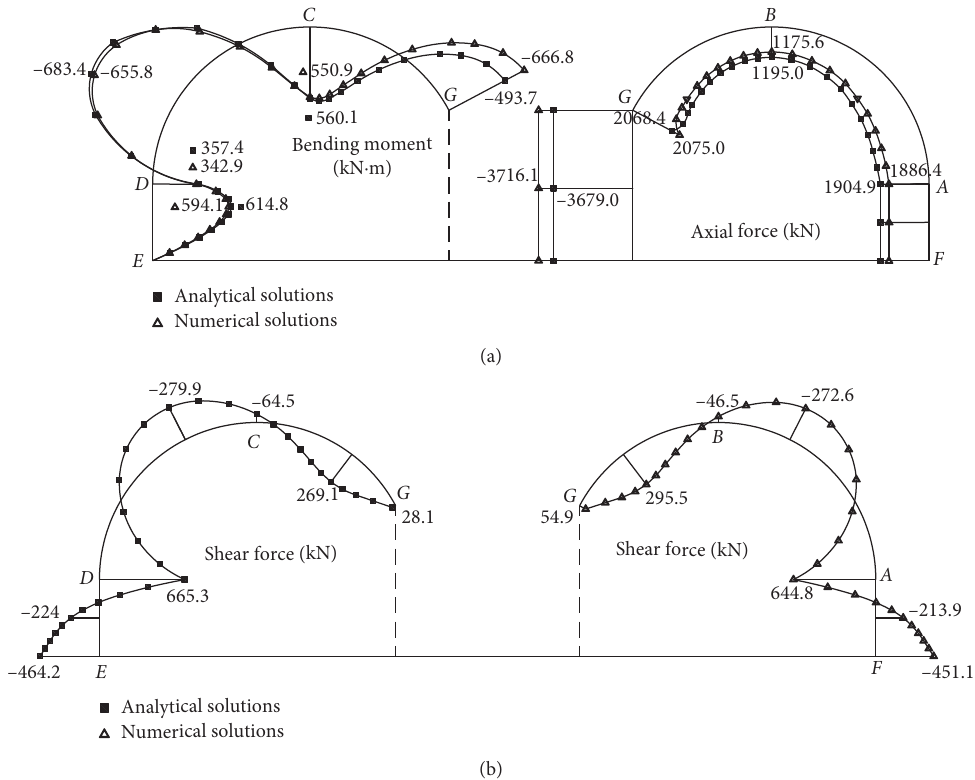
Figure 9: Comparison of the internal forces obtained from the analytical solutions and numerical simulations: (a) bending moment and axial force; (b) shear